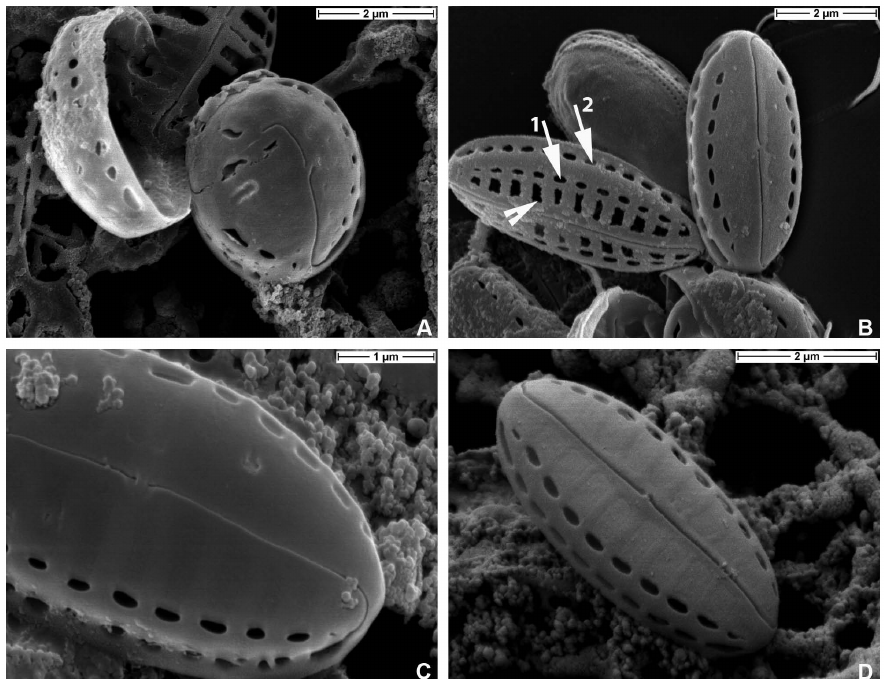
Figure 3. Biremis panamae sp. nov., SEM: external valve views . A. Two valves of exceptionally small specimens after size reduction in culture, showing teratological development of the raphe. B. Two well developed specimens, one eroded and showing the valve face striae with destroyed occlusions. Arrowhead points to corroded occlusions of the valve face striae. Note also two rows of foramina, one on the valve face (arrow 1) and the other on the valve mantle (arrow 2). C. Detail of a valve with intact pore occlusions, showing the external central raphe endings slightly bent towards the valve secondary side and strongly bent apical raphe end, which terminates in one of the foramina positioned on the valve mantle. D. Fully intact, uneroded valve, showing the valve face areolae completely closed with hyaline occlusions (hymenes), which are slightly depressed below elevated interstriae